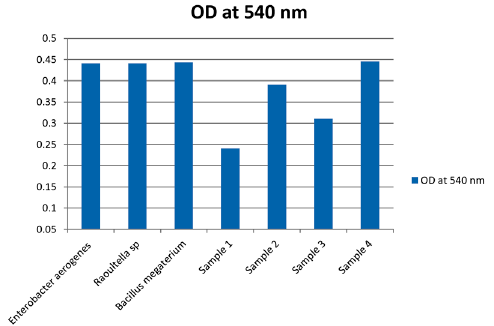
Fig. 2. Growth potential of the selected bacterial